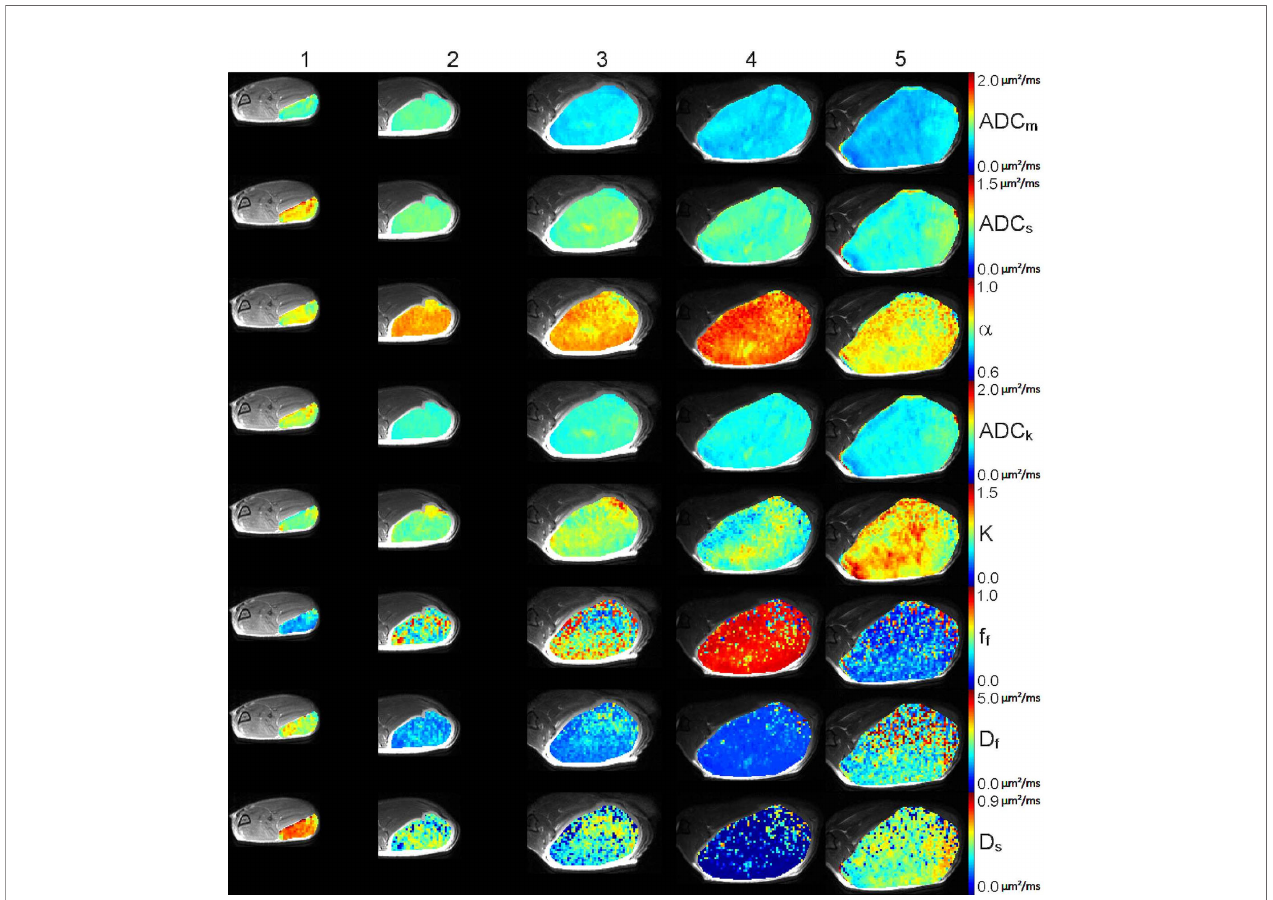
FIGURE 2 | High b-value DWI data of a representative tumor: T2-weighted image fused with parametric maps for ADC m, ADC s , a , ADC k , K, f f , D f , and D s parameters are shown, and represent different degree of tumor homogeneity between week 1 (column 1), week 2 (column 2), week 3 (column 3), week 4 (column 4). Furthermore, the second repetition done on week 4 is shown (column 5). The parametric maps are scaled as follows: ADC m (A1 − 5) min − max: 0 − 2.0 µm 2 /ms, ADC s (B1 − 5) min − max: 0 − 1.5 µm 2 /ms, a (C1-5) min − max: 0.6 − 1.0, ADC k (D1 − 5) min − max: 0 − 2.0 µm 2 /ms, K (E1 − 5), min − max: 0 − 1.5, f f (F1 − 5), min − max: 0 − 1.0,